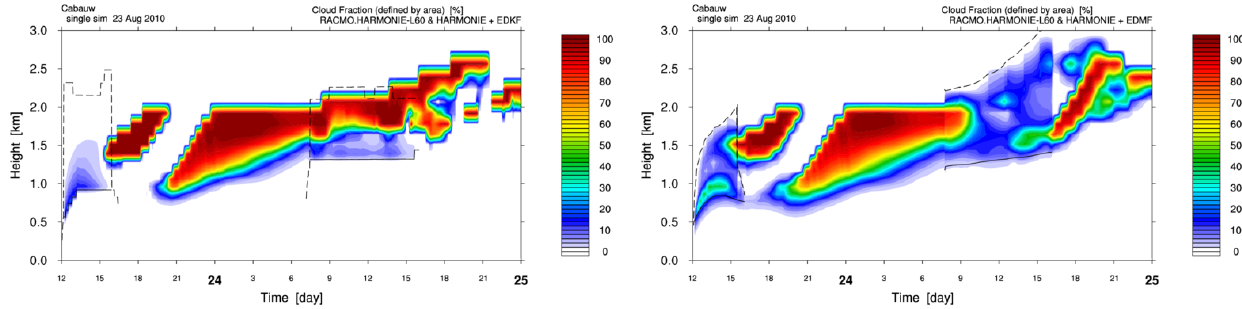
Figure 1. cloud fraction of EDKF(left), EDMF(right) for the 24th of August 2010 (analysis 23 August 2010 1200 UTC) . The solid line is lifting condensation level and dashed line is the updraft termination height.